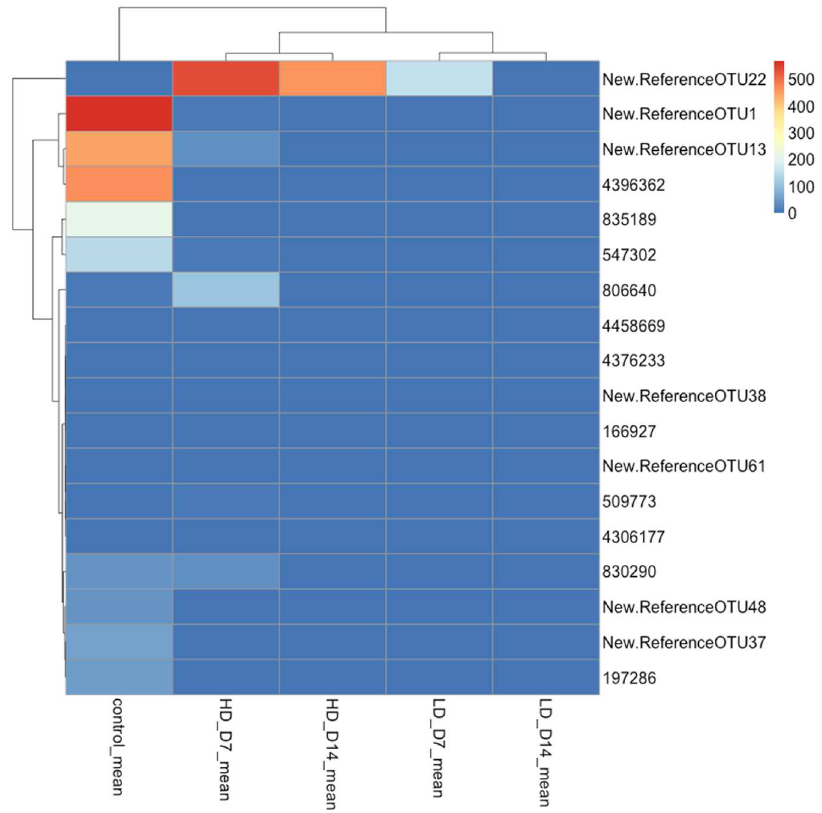
Fig 4. Heat map showing the mean relative abundances of OTUs that were found to be significantly different in control and SAV3 infected experimental groups. The taxonomicclassificationof each OTU numberis shown in Table 2. LD_D7: low-doseinfected day 7; LD_D14:low-doseinfected day 14; HD_D7: high-dose infected day 7; HD_D14:high-doseinfected day 14.